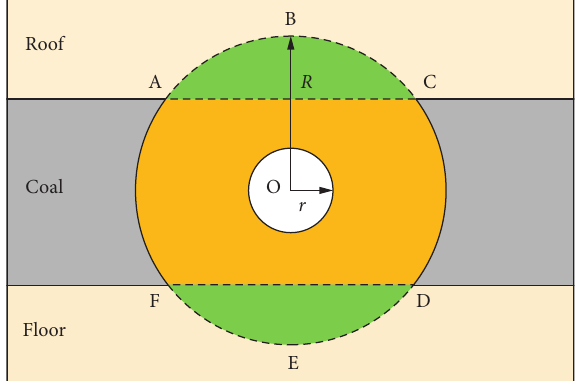
Figure 2: Structural diagram of the roadway surrounding